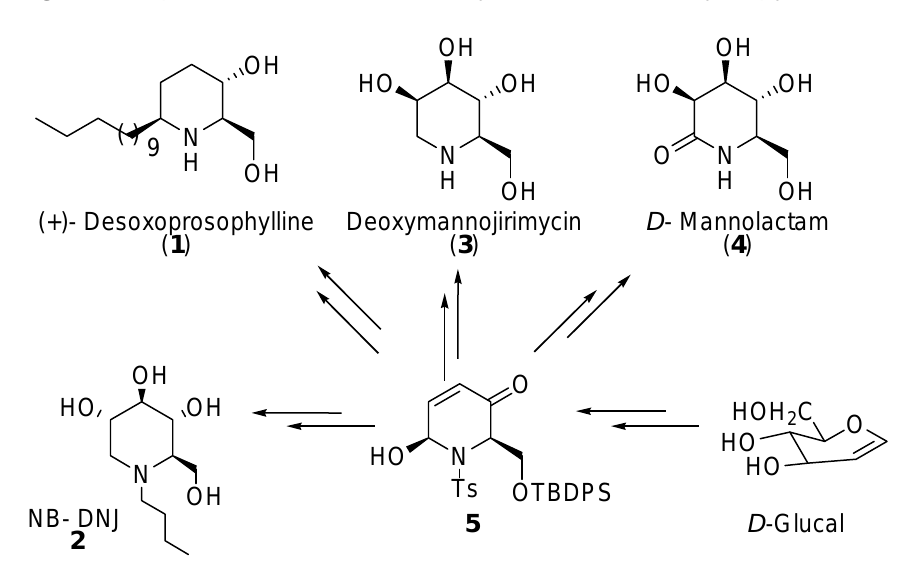
Figure 1. Piperidine Alkaloids and Key Intermediate Dihydropyridone 5